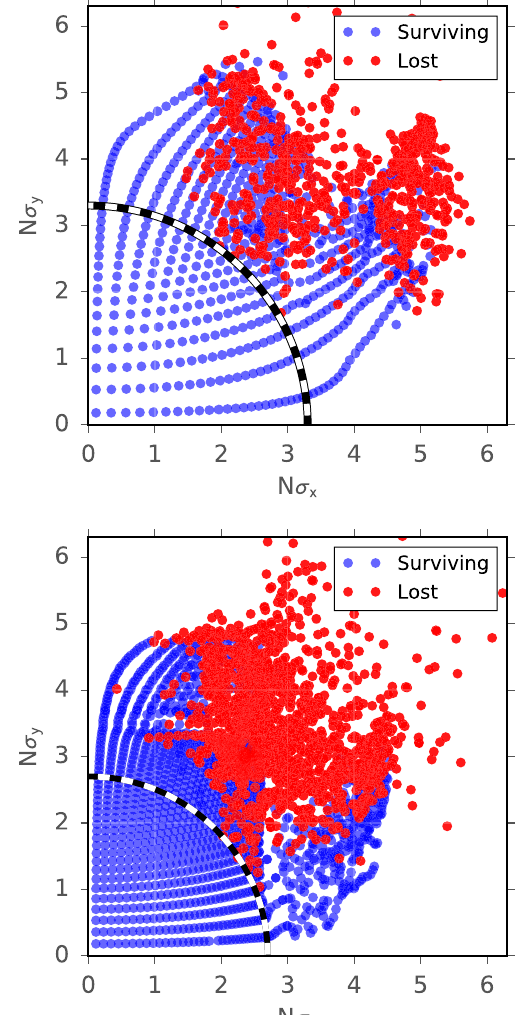
FIG. 7. Forced dynamic aperture at injection with Landau octupoles at 40 A. The top figure shows the forced dynamic aperture for a model including magnetic errors, while the bottom figure shows the forced dynamic aperture for a model including geometrical rotational errors as well as magnetic errors. A reduction of forced dynamic aperture is observed when including the geometrical rotational errors in the